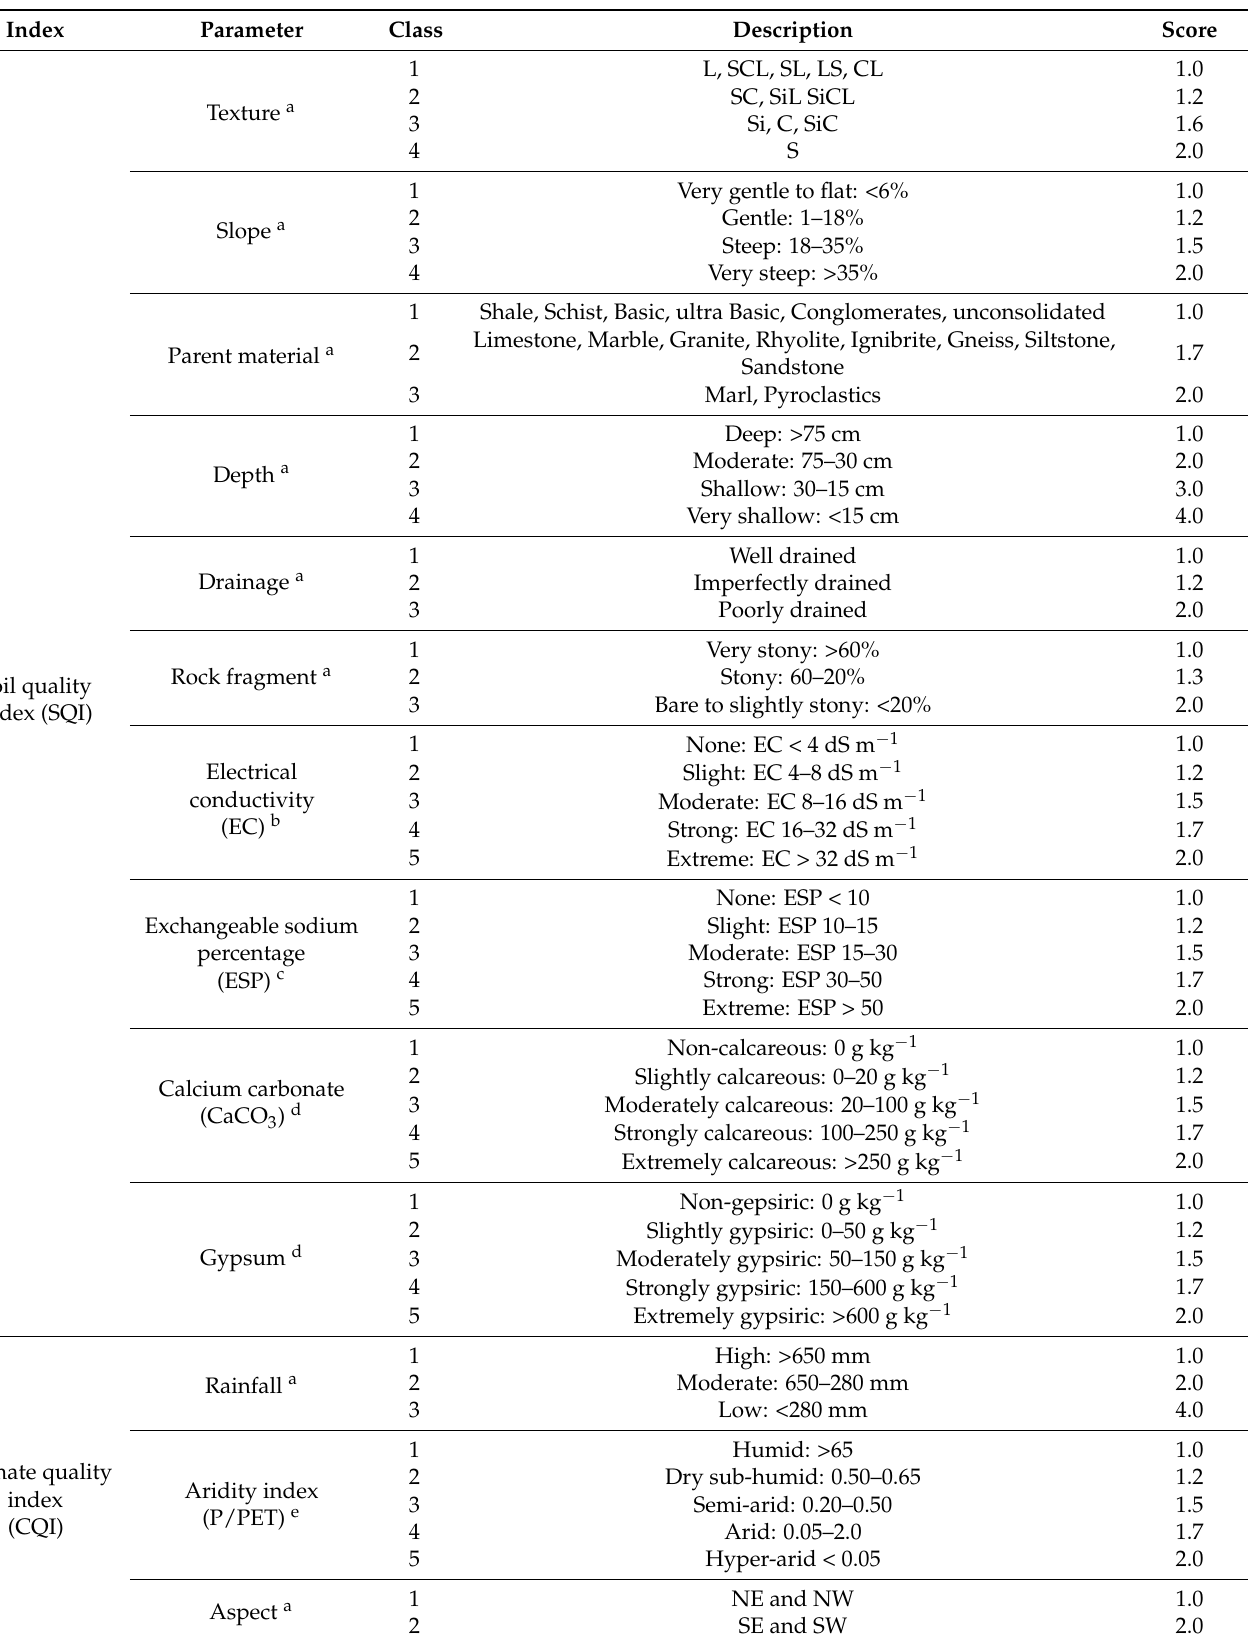
Table 1. Dataset included in the modified MEDALUS